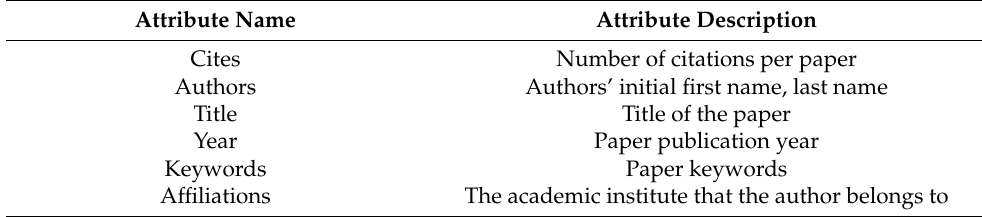
Table 2. The key attributes of the used dataset.